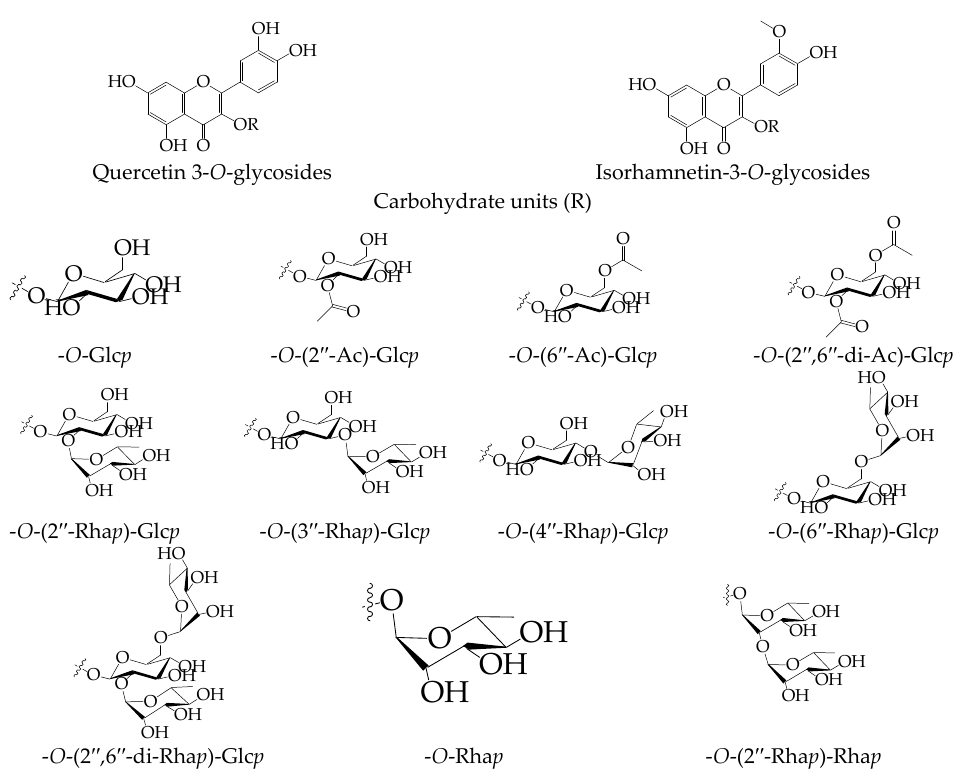
Figure 3. Structures of quercetin and isorhamnetin glycosides from C. officinalis . Abbreviations